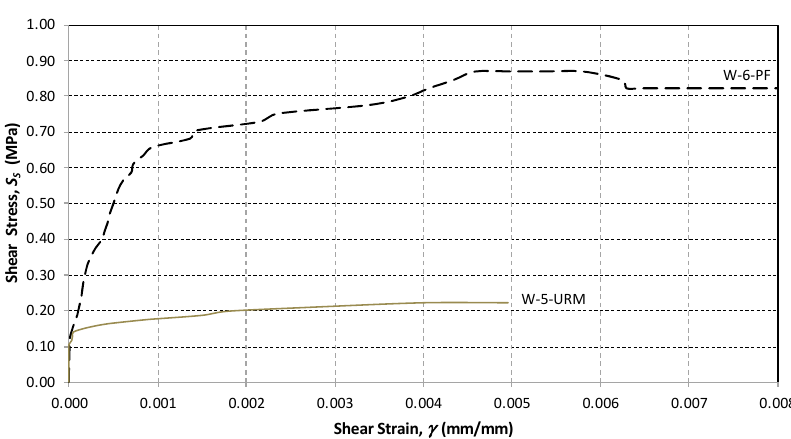
Figure 16. Shear stress versus shear strain plot (large-size panels).